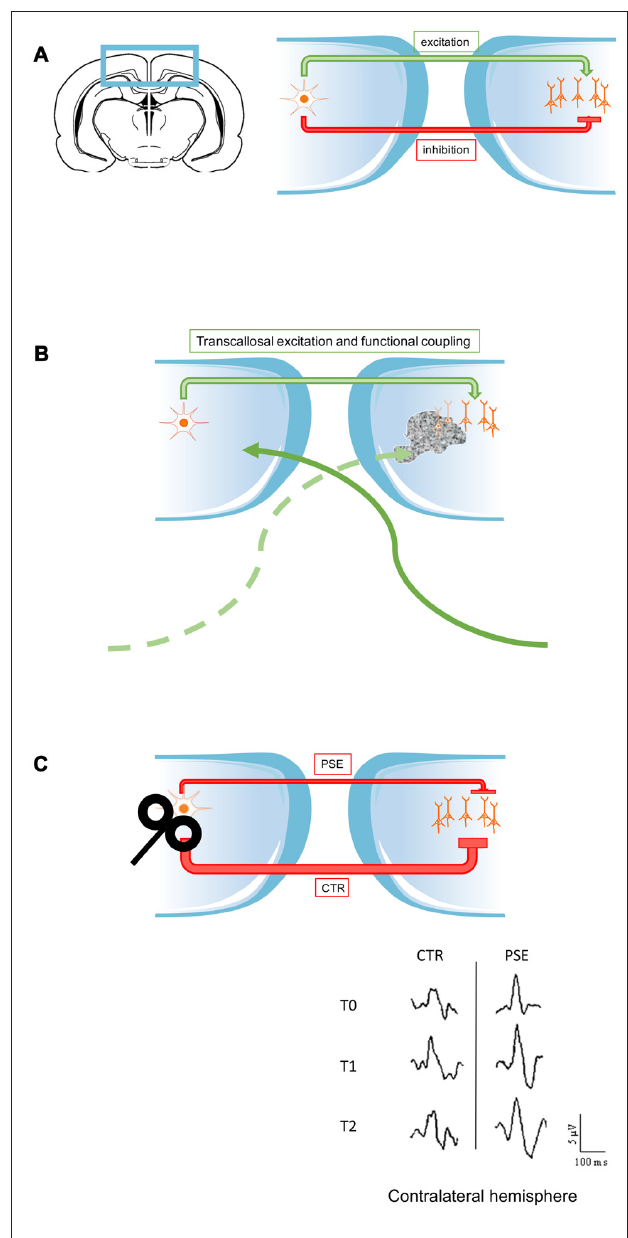
FIGURE 1 | Schematic illustration of the role of interhemispheric input in visual physiology and pathology. (A) In physiological conditions the corpus callosum (CC) provides both excitatory and inhibitory input to the contralateral hemisphere (see first section of this review). (B) Callosal communication is at the basis of the functional coupling of the two hemispheres, but it could also contribute to provide excitatory input to spared cortical regions, when lesions occurred in the opposite side (Kiper et al., 2002; Knyazeva et al., 2002; Kavcic et al., 2015). (C) In some pathological conditions, the transcallosal pathway could be impaired and transfer abnormal inhibitory input. In photosensitive patients (PSE), following low frequency repetitive transcranial magnetic stimulation (rTMS) in one side, the untreated side displayed a persistent enhancement of visual evoked potentials (VEPs) amplitude (T2). This suggests that less effective inhibition provided by callosal projections might be at the basis of the prolonged increase of visual responses measured in the untreated side. This may potentially contribute to the pathophysiology of PSE (Bocci et al.,